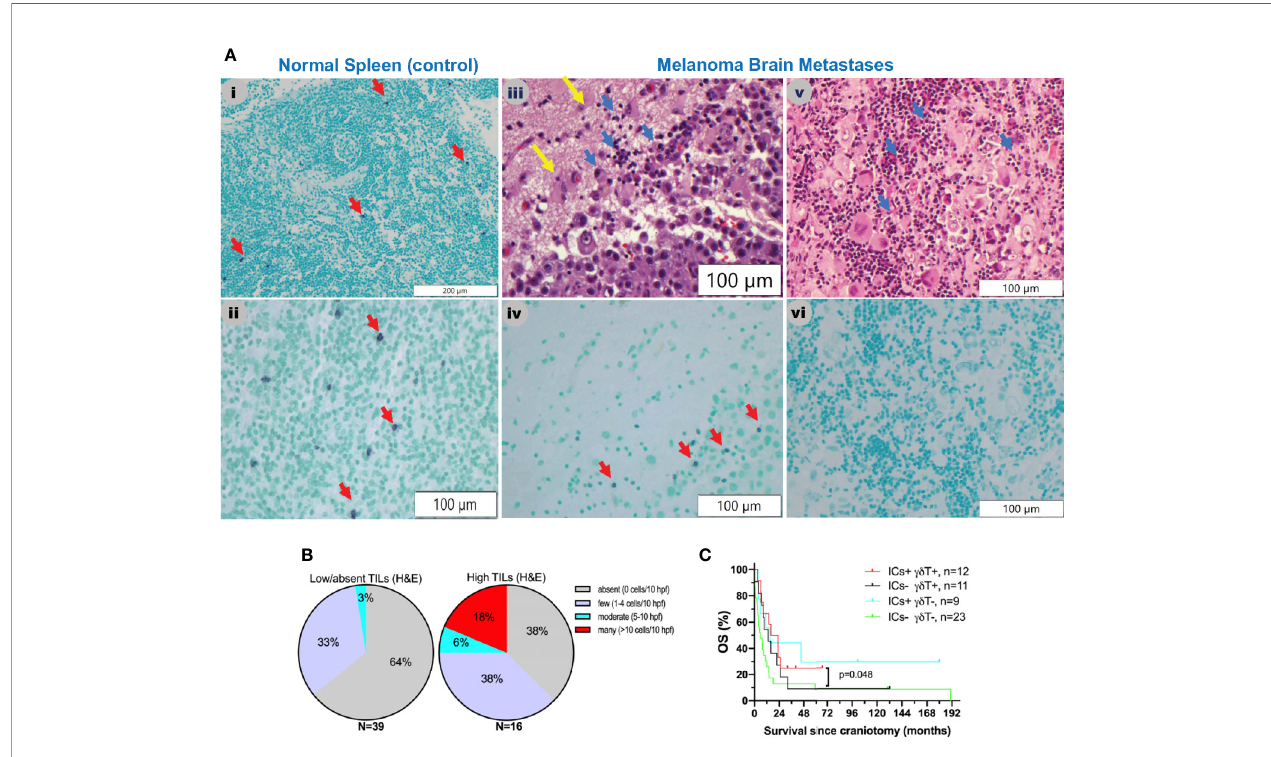
FIGURE 3 | gd T cells in melanoma brain metastases from the University of North Carolina at Chapel Hill craniotomy cohort using a T-cell receptor (TCR) delta chain mouse monoclonal antibody. (A) Abundance of gd T cells in relation to tumor-in fi ltrating lymphocytes (TILs) as detected by routine hematoxylin and eosin (H&E) staining. See Patients, Materials and Methods for details. i and ii. Staining of a normal human spleen as a positive control. Please note that the gd T stain is violet (purple) membranous stain (red arrows), whereas the nuclear counterstain is light green. iii and iv. Representative images from a MBM that contains TILs (blue arrows, iii) and gd T cells (red arrows, iv). Yellow arrows indicate normal brain. v and vi. Representative images from a MBM containing TILs (blue arrows, v) but not gd T cells (vi). (B) Abundance of gd T cells in melanoma brain specimens that bear absent/low (left pie chart) versus high (2+, 3+) TILs (right pie chart). (C) Exploratory overall survival (OS) analysis (Kaplan-Meier method) according to the presence of TILs (H&E stain) and treatment with immune checkpoint inhibitors IICs following